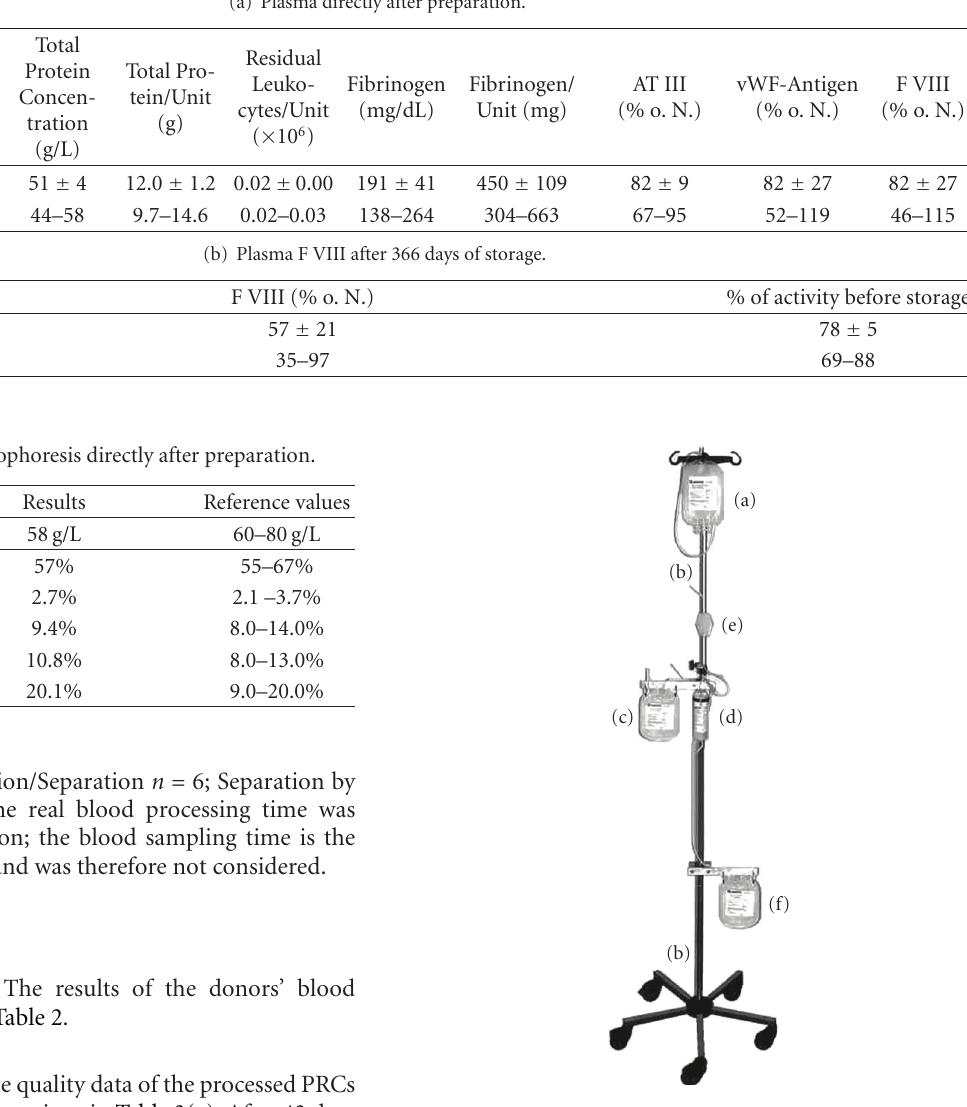
Figure 2: Complete gravity-separation system. (a) Donation bag prefilled with 63 mL CPD, (b) Mean stand, (c) Erythrocyte bag prefilled with 100 mL extended storage medium (PAGGS-M), (d) Hollow-fibre filter, (e) Leukocyte filter, (f) Plasma